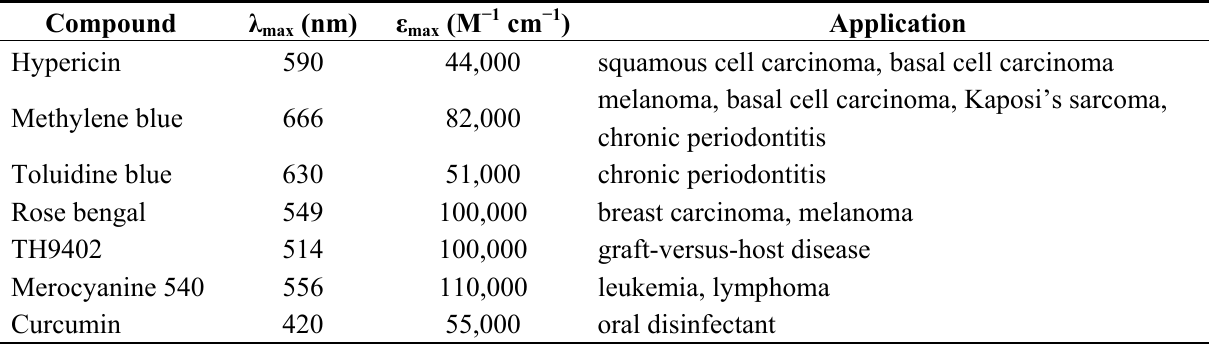
Table 3. Examples of non-porphyrin PDT